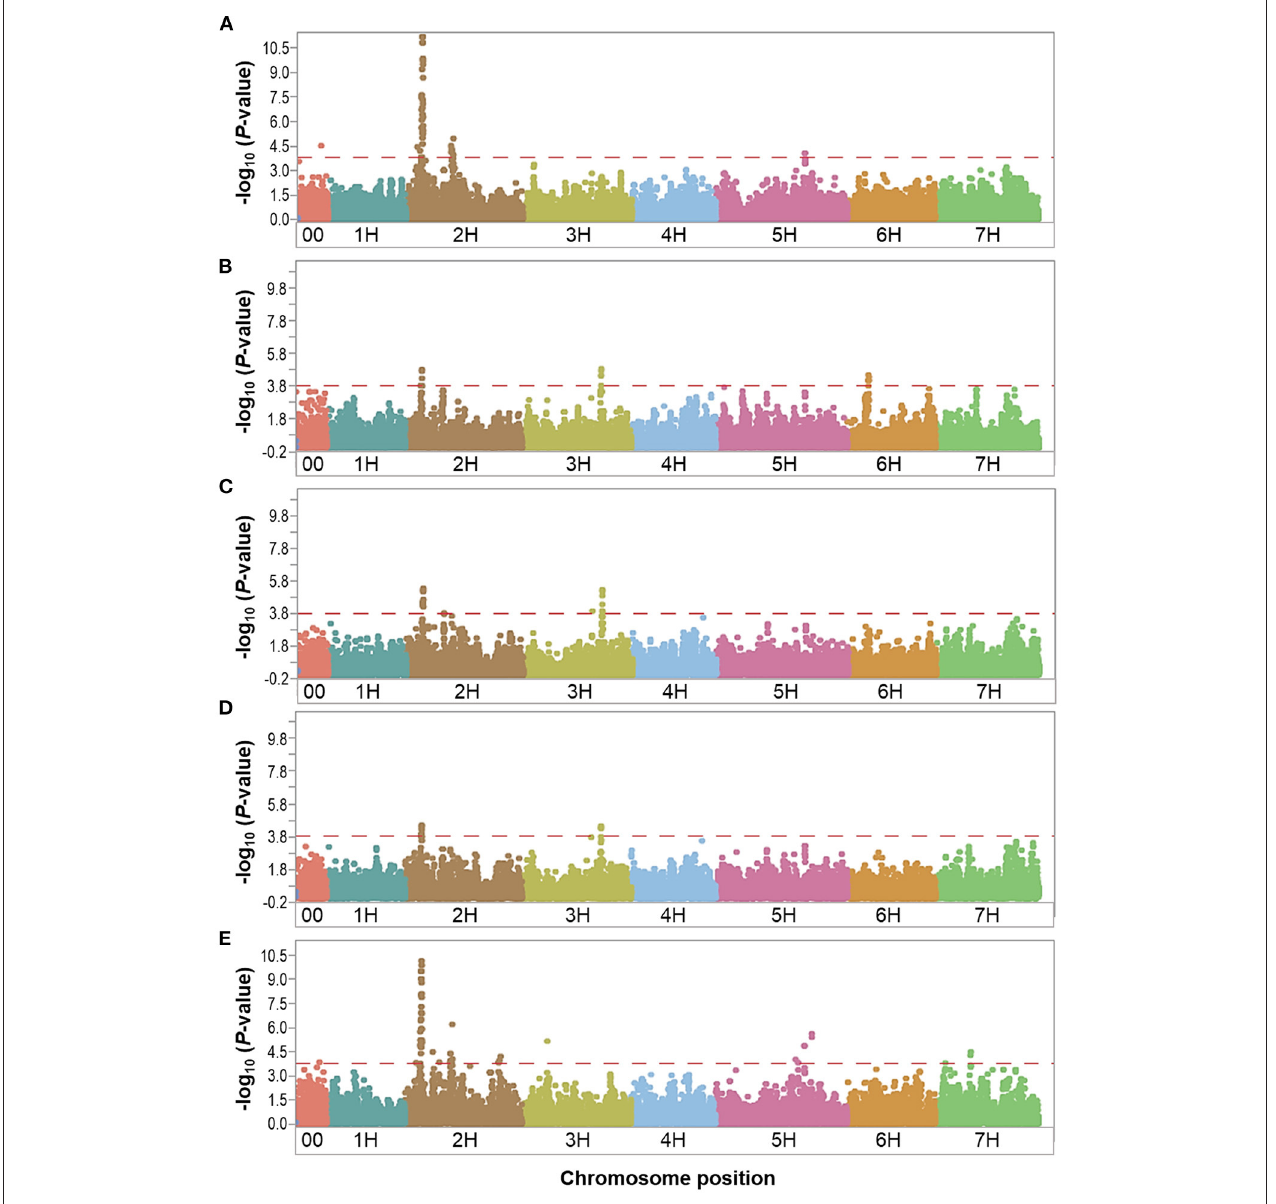
FIGURE 3 | Manhattan plots resulting from the SNP-based GWAS in overall control under field conditions. Manhattan plots for Biomass (BIO), Spikes per plant (SP), Grains per plant (GP), Kernel weight per plant (KWP), and Plant height (PH) are shown in (A–E) , respectively, and the x-axis shows SNP loci along the seven barley chromosomes. The horizontal red line shows the genome-wide significance threshold P -value of 1.6 × 10 − 4 or –log 10 ( P -value) value of 3.8. GWAS was performed using the MLM (Q + K) model in JMP Genomics for the field